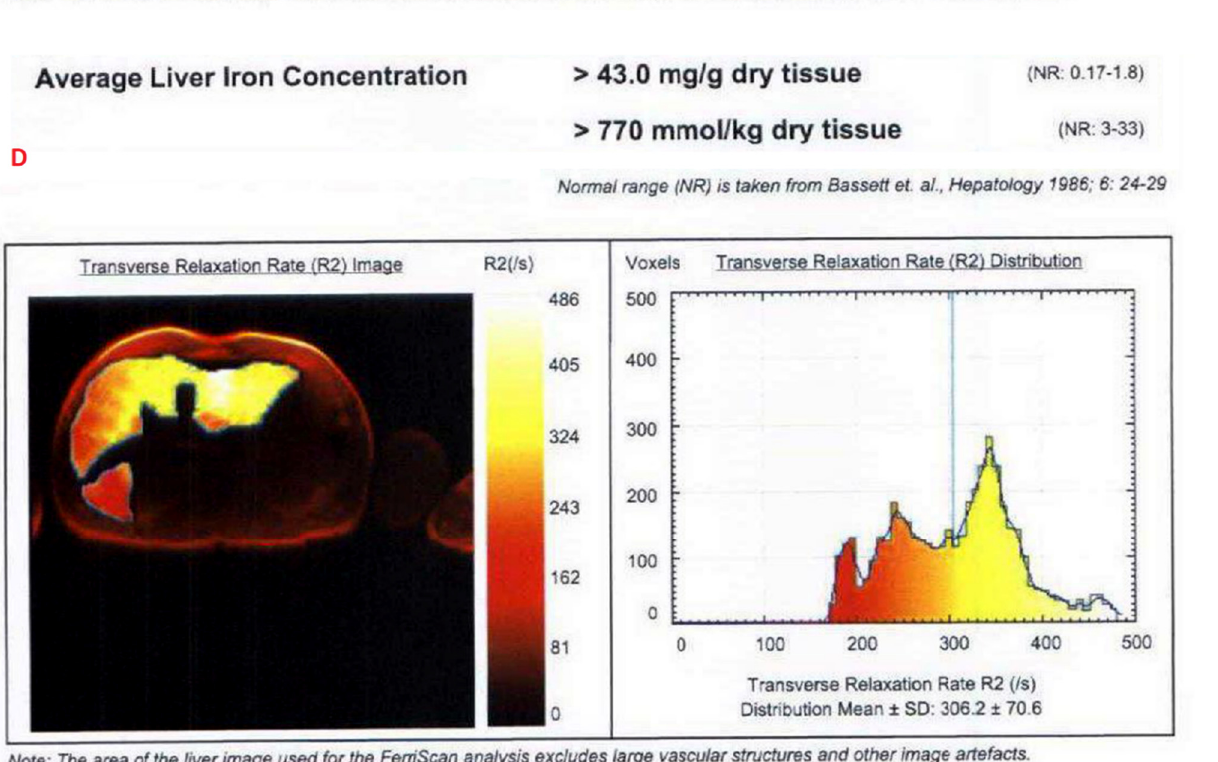
Figure 1. Representative images from anonymized FerriScan ® reports of two different patients in the upper ( A , B ) and lower panels ( C , D ) at two time points (color scale shows the range of R2).